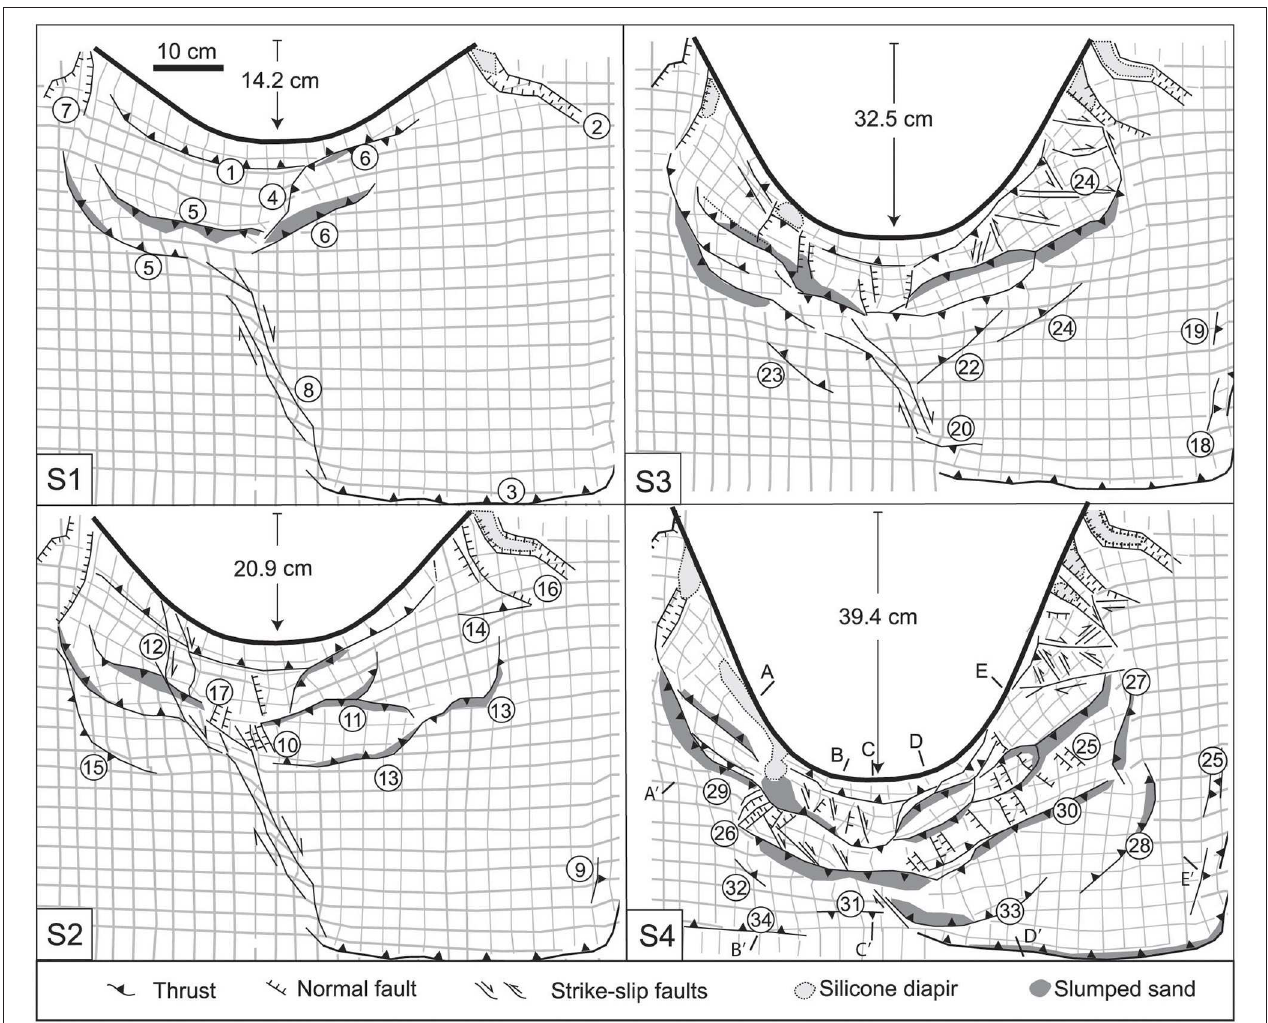
FIGURE 6 | Line drawings of Model 4-1 at different stages (S1–S4) . The numbering indicates the relative chronology of the structures. The apex displacement is indicated for each stage. A–E: localization of cross sections of Figure 9